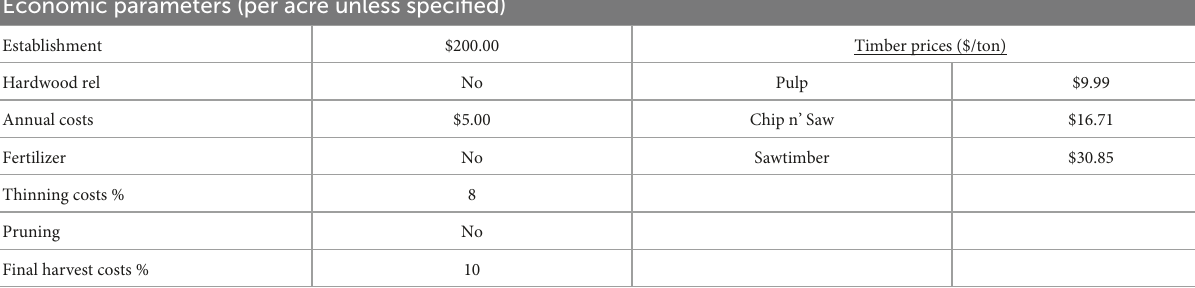
TABLE 3 Economic parameter inputs for pine plantation simulations in PTAEDA4.0.